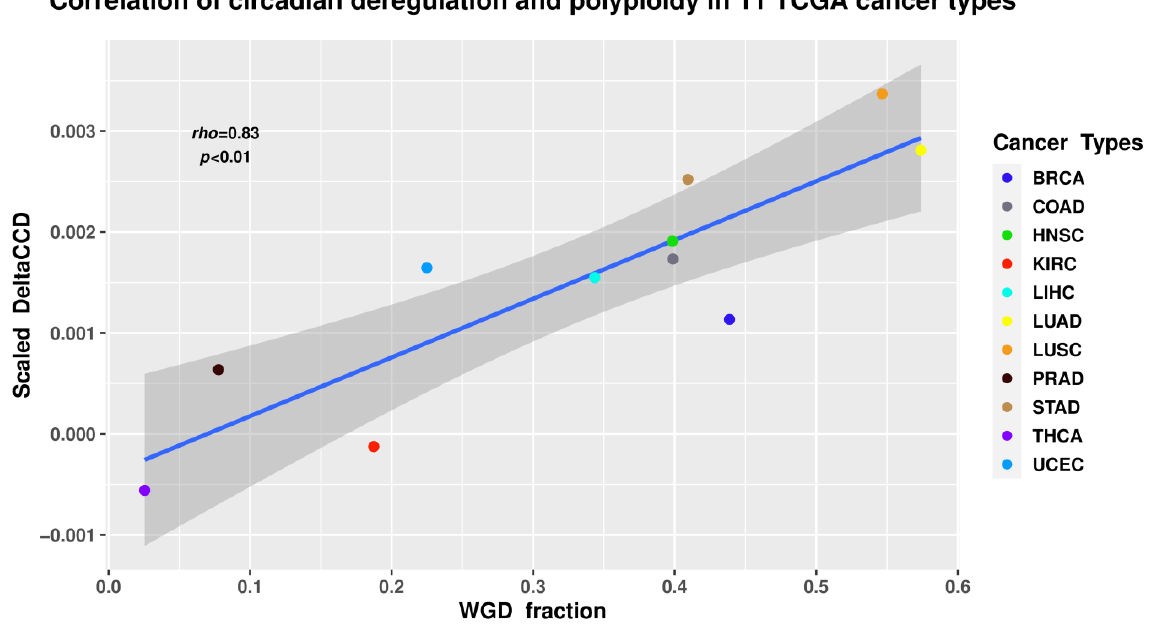
Figure 4. The ∆ CCD coefficient of circadian deregulation positively correlates with the Figure 4. The Δ CCD coefficient of circadian deregulation positively correlates with the proportion of WGD in the samples of 11 tumour types from The Cancer Genome Atlas (TCGA) database.